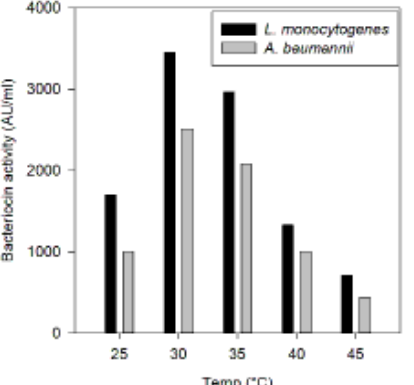
Fig. 2. Effect of temperature on bacteriocin production against L. monocytogenes MTCC 657 and A. baumannii MTCC